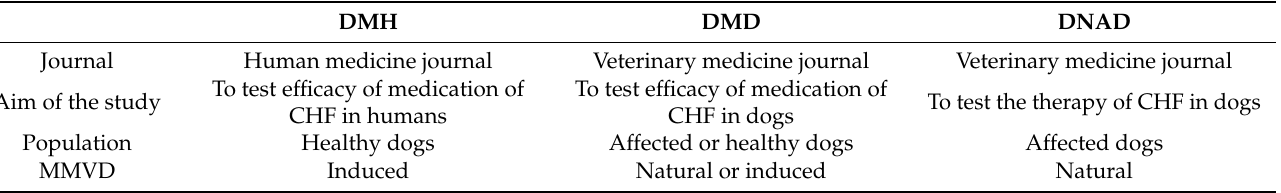
Table 1. Subclassification of the studies into three categories.